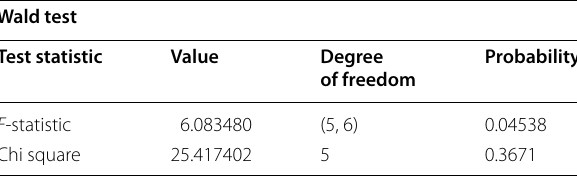
Table 1 Asymmetric cointegration test Source :